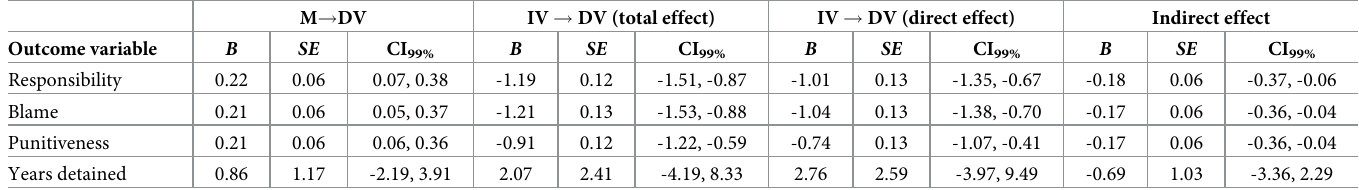
Table 5. Mediation model statistics: Effects of defense of mental impairment on crime judgments via agency (Study 2). M !